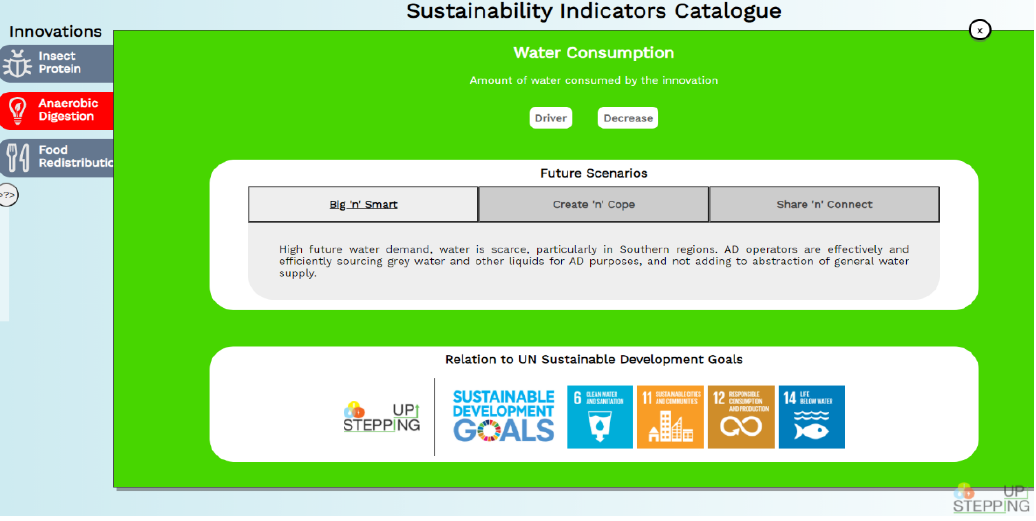
Figure 4. Example of Single Sustainability Indicator (SI) display for Future Scenarios & Relationship to SDGs—Cleaner Water.